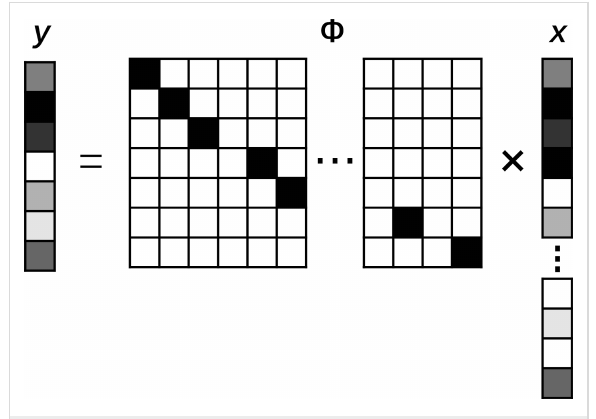
Figure 2: Mathematical model of compressed-sensing AFM imaging. The image obtained by AFM can be regarded as a two-dimensional matrix, and each pixel of the image is an element of the matrix. The imaging process can be regarded as collecting the element of the vector x , the Φ is the measurement matrix, and y is the measurement